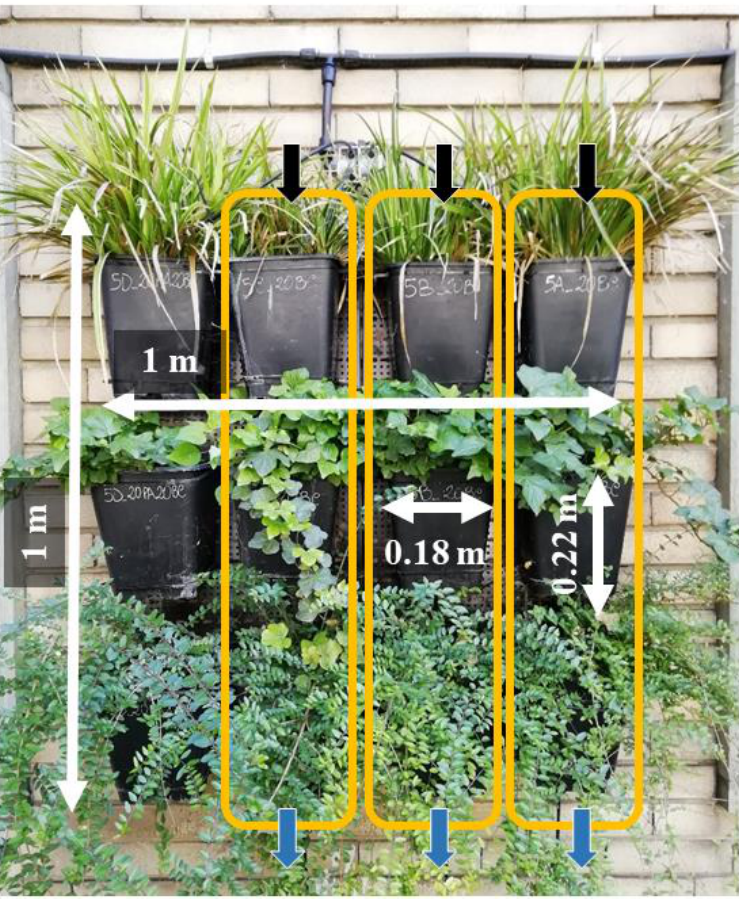
Figure 1. One of the four tested modules of the green wall system. Table 1. Details on the tested configurations (% by volume).